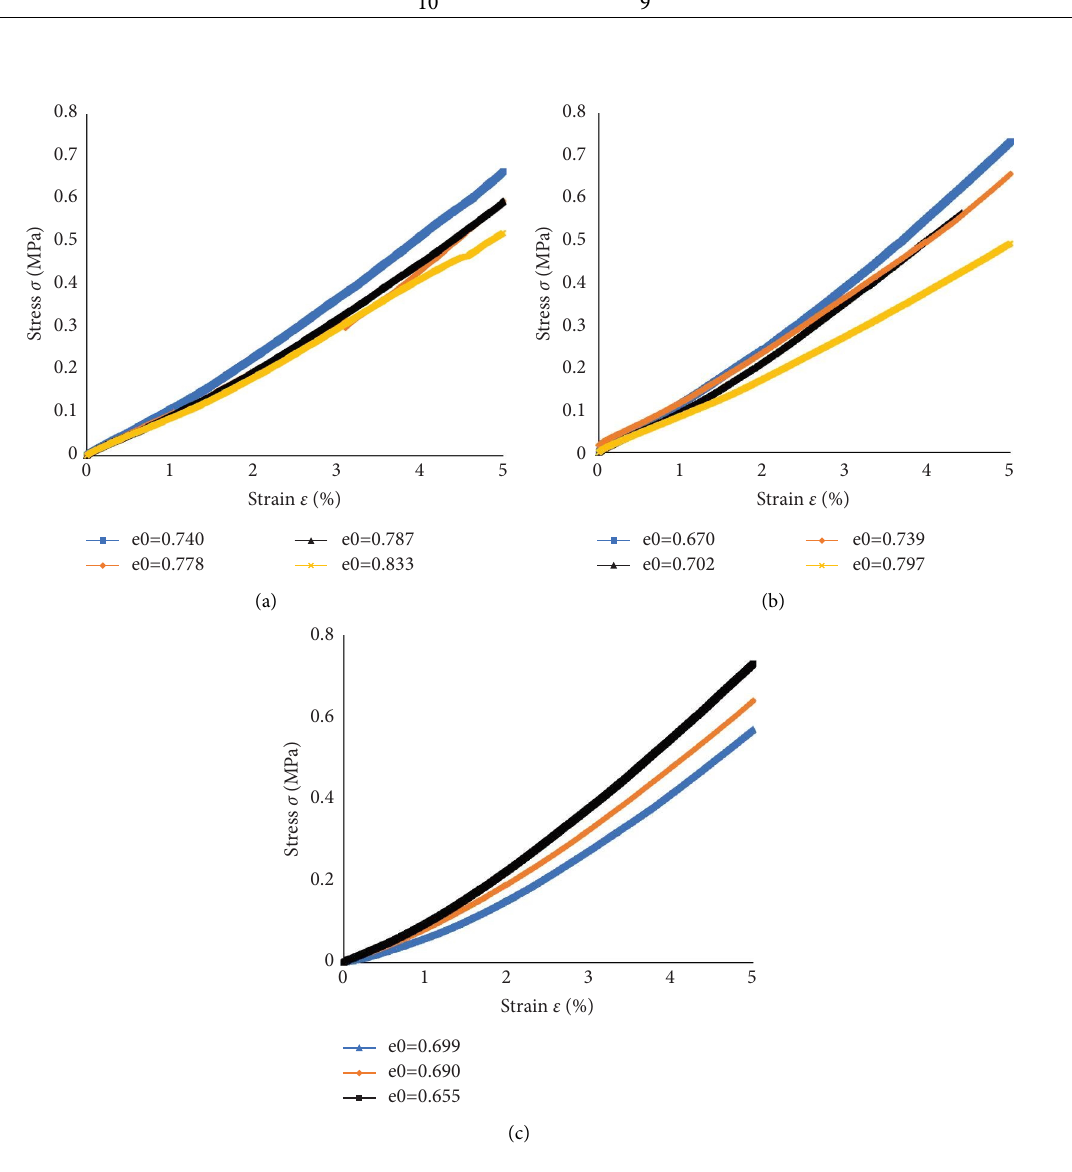
� 6 ( B � 120mm, d � 20 mm). (c) R d